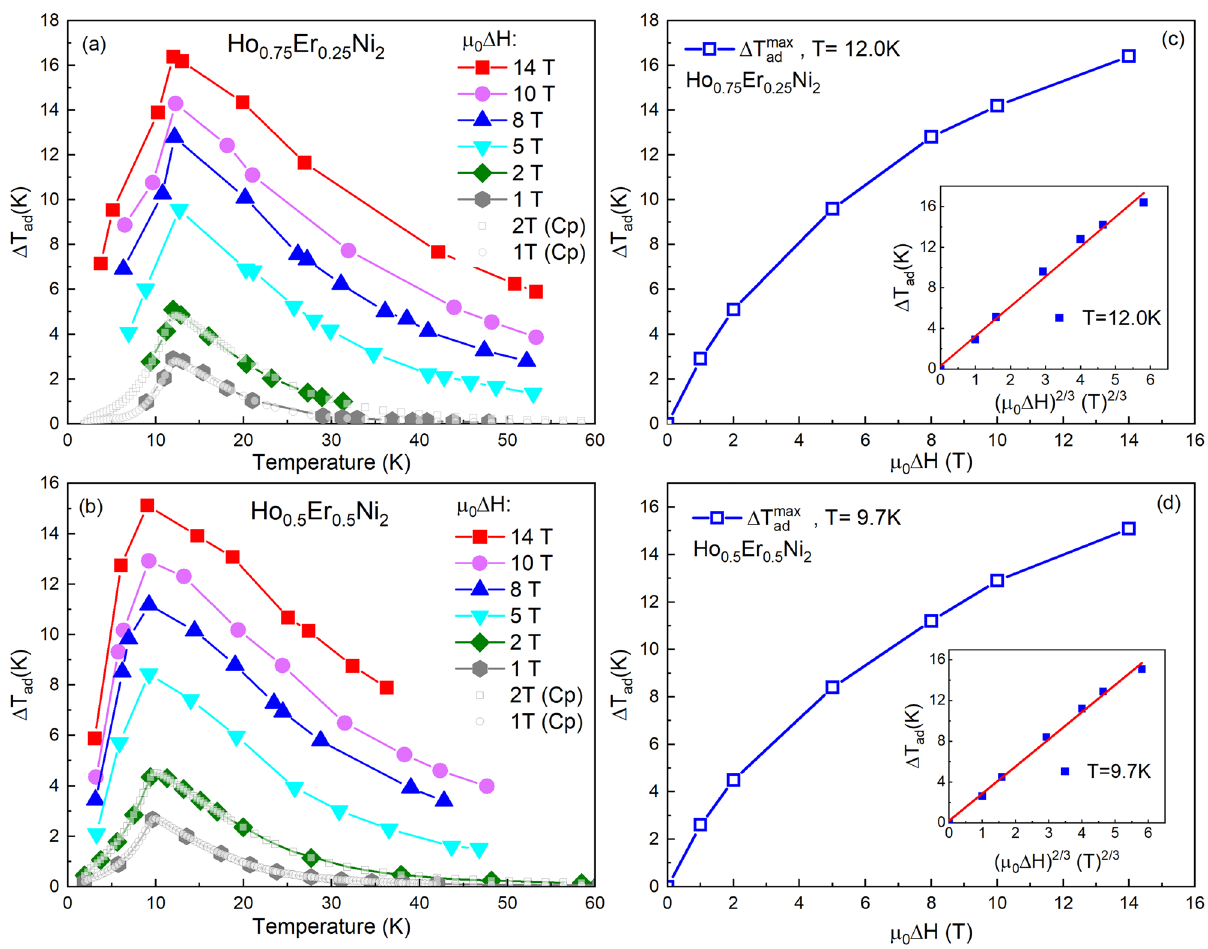
Figure 6. Temperature dependences of the adiabatic temperature change, Δ T ad , as obtained from the heat capacity data (filled symbols) and from direct measurements (open symbols) for Ho 0.75 Er 0.25 Ni 2 ( a ) and Ho 0.5 Er 0.5 Ni 2 ( b ) at different magnetic field changes µ 0 Δ H and maximum adiabatic temperature change, Δ T ad max , for